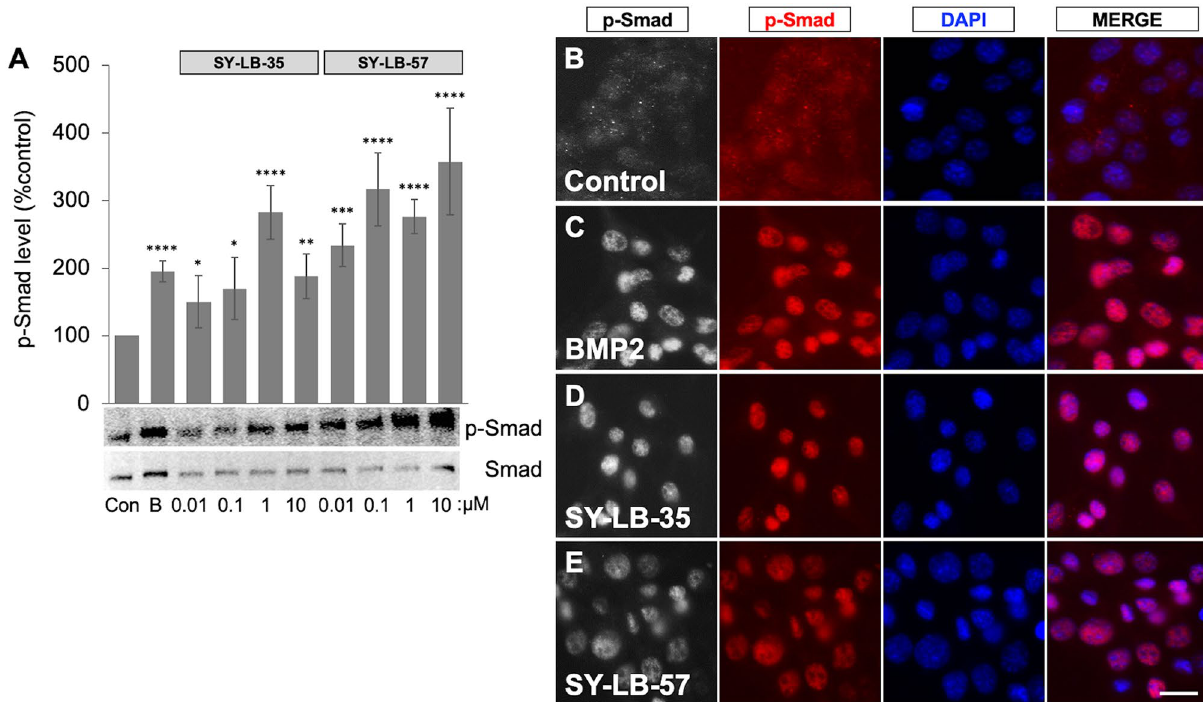
Figure 5. Smad phosphorylation and nuclear translocation in the presence of SY-LB-35 or SY-LB-57. ( A ) Serum-starved C2C12 cells were treated with increasing concentrations of SY-LB-35 or SY-LB-57 (0.01–10 µM) for 30 min. BMP2 (50 ng/mL) was used as a positive control. Western blot analysis using anti-p-Smad and anti-total Smad antibodies showed that SY-LB-35 and SY-LB-57 mimicked BMP2 by increasing Smad phosphorylation levels. Quantification of p-Smad levels compared to control confirms significant upregulation of p-Smad following 30-min stimulation with BMP2 (195%, **** p < 0.0005), SY-LB-35 (0.01 µM: 150%, 0.1 µM: 170%, * p < 0.05; 1 µM: 282%, **** p < 0.0005; 10 µM: 188%, ** p < 0.01) and SY-LB-57 (0.01 µM: 234%, *** p < 0.001; 0.1 µM: 316%, 1 µM: 276%, 10 µM: 357%, **** p < 0.0005). Levels of p-Smad were normalized